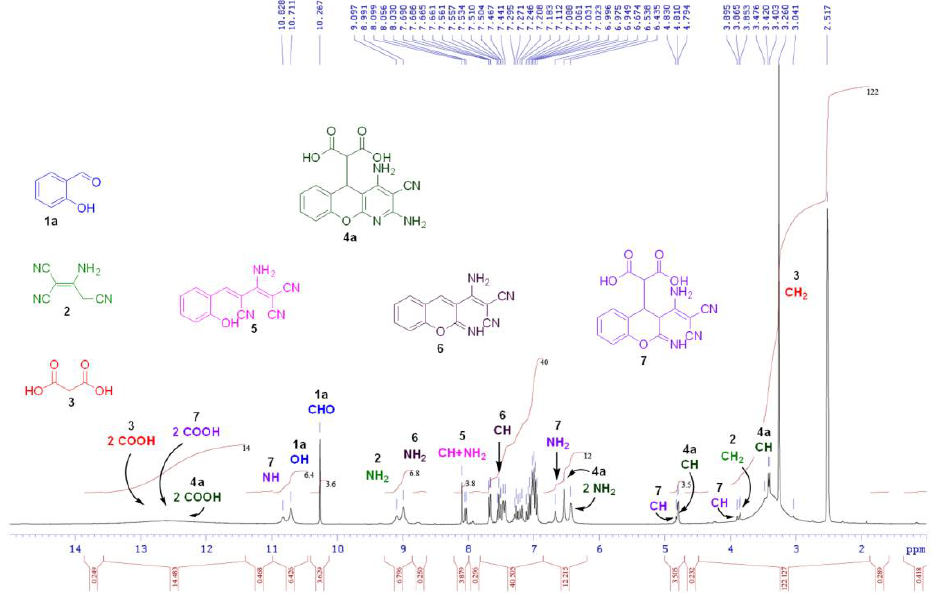
Figure 2. Representative 1 H-NMR spectrum of multicomponent reaction in DMSO- d 6 at 313 K recorded 45 min after dissolution.